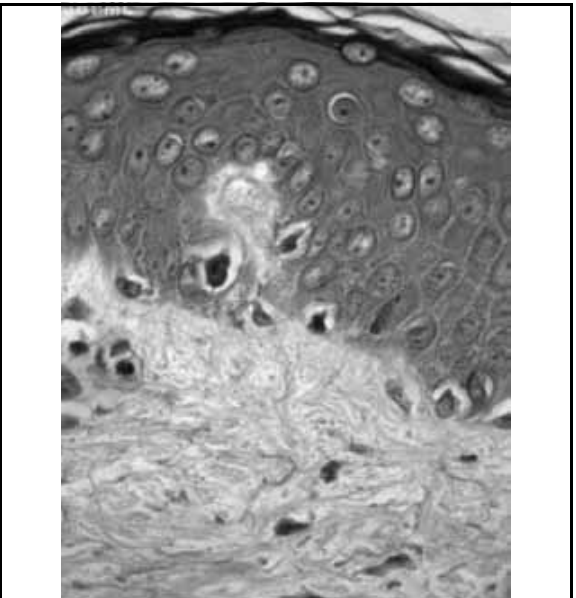
Figura 5 – Pleomorfismo citológico. Hematoxilina e eosina